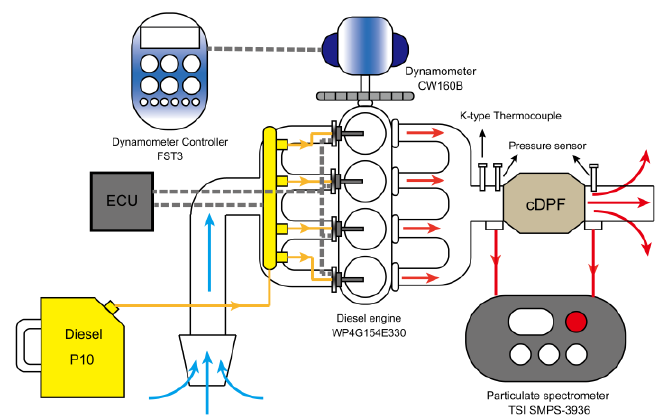
Figure 7. The schematic of the experimental setup. Table 1. The main specifications of the diesel engine.